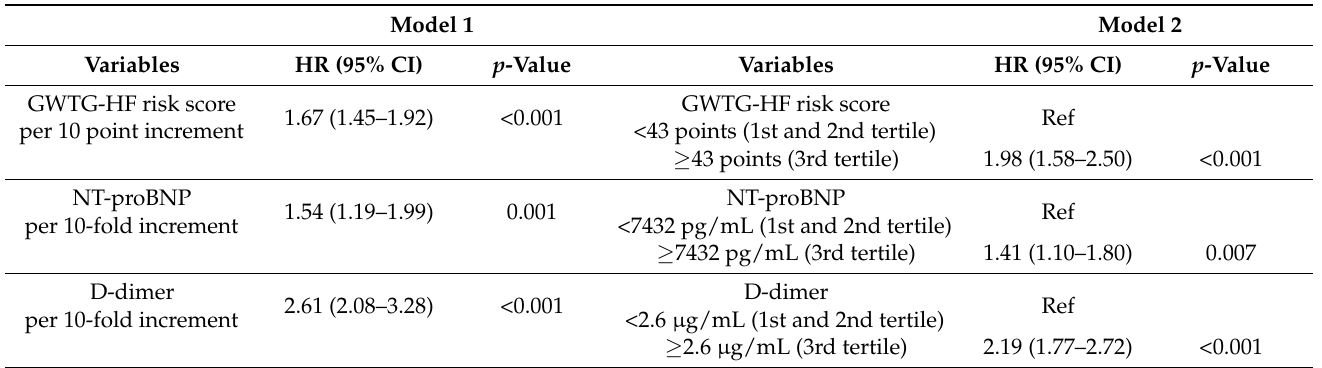
Table 2. Multivariate predictors of all-cause mortality in all study populations.